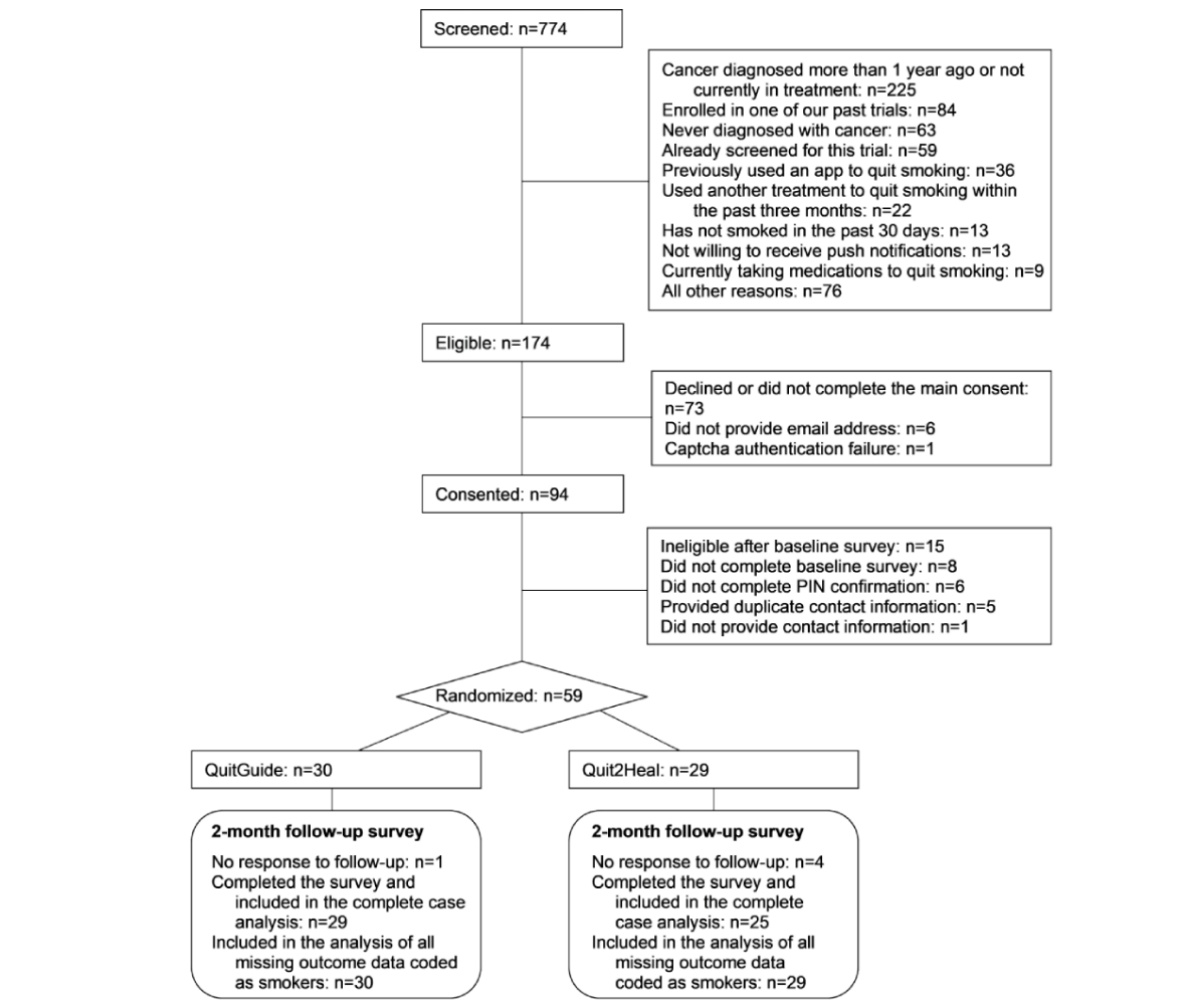
Figure 1. Participant flow